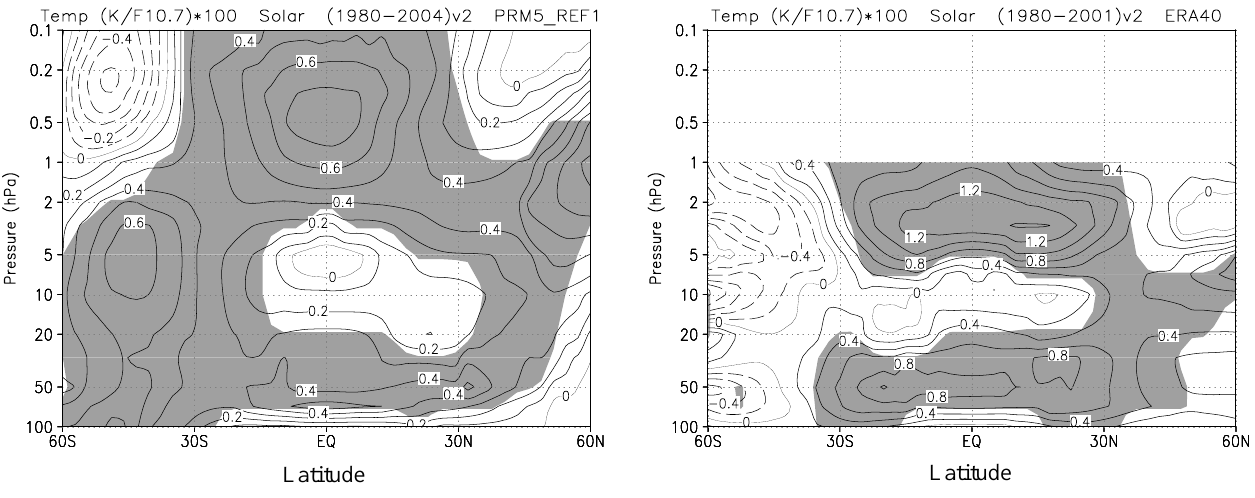
Latitude Latitude Fig. 16. Latitude-pressure cross sections of the solar temperature signals in K per 100 solar units from 100 to 0.1hPa between 60 ◦ S and 60 ◦ N for the simulation (left) and observation (ERA-40) (right). Contour interval is 0.1 for the simulation and 0.2 for the observation, and shading denotes the 95% confidence level (t-test). O3 (%/F10.7)*100 Solar (1980-2004)v2 PRM5_REF1